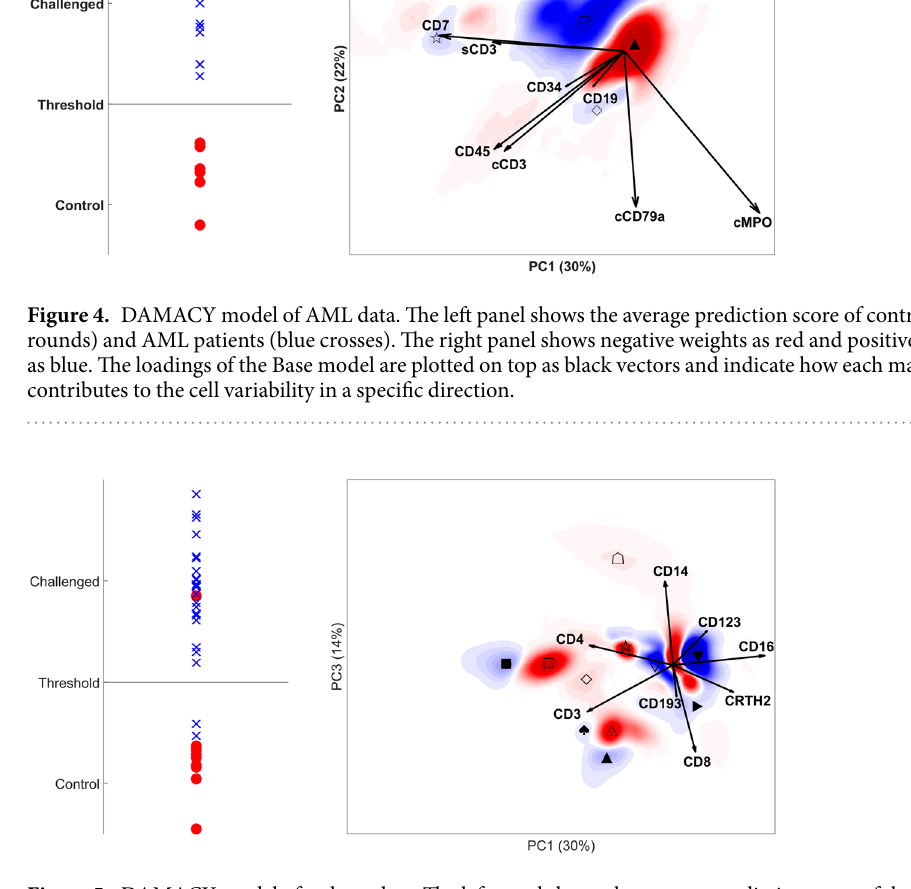
Figure 5. DAMACY model of asthma data. The left panel shows the average prediction score of the OPLS-DA model of controls as red rounds and asthma individuals as blue crosses. The right panel shows negative weights as red and positive weights as blue. The loadings of the Base model are plotted on top as black vectors and indicate how each surface marker contributes to the cell variability in a specific direction within the model. The symbols indicate the centroid of that coloured area that are representative for different cell populations (see Table